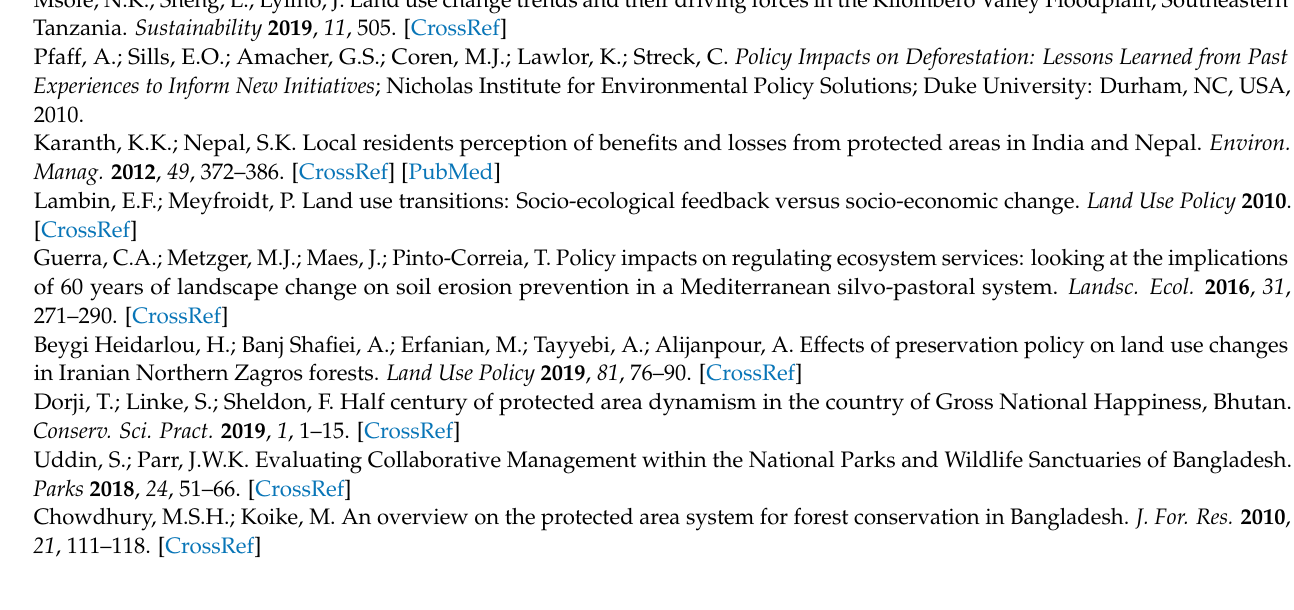
Table S2: Classification of land use and land cover (LULC), Table S3: Accuracy assessment, Table S4: Transition matrix of LULC in Rema-Kalenga Wildlife Sanctuary (RKWS) between 1994 and 2018 (unit: hectare), Table S5: Annual rates of change, Figure S1: Examples of primary data sources in RKWS. Clockwise: (a participatory mapping, (b) GPS data, (c) informal discussion with local residents, (d) settlement in the protected area (PA), (e) commercial land use, and (f) non-commercial agricultural land use, Figure S2: Major LULC conversions from 1994 to